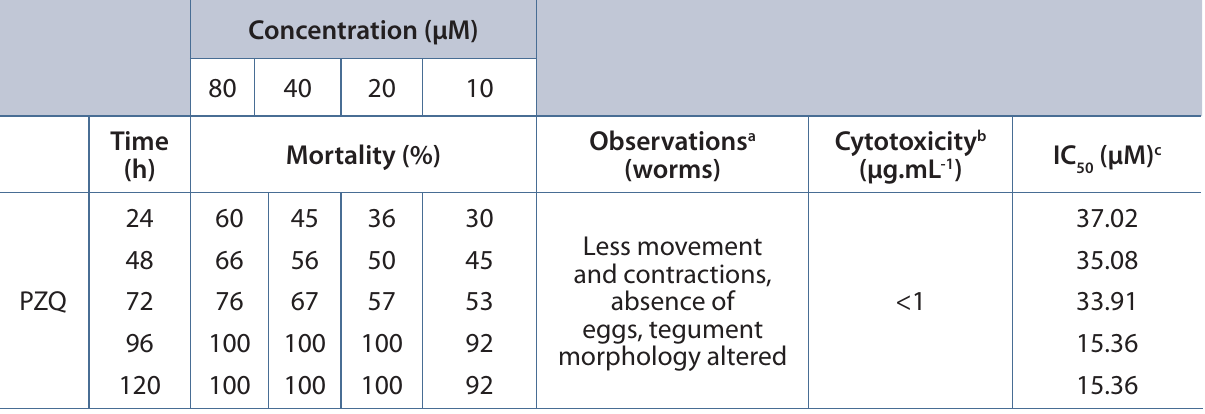
Table 2. In vitro effects of praziquantel against Schistosoma mansoni adult